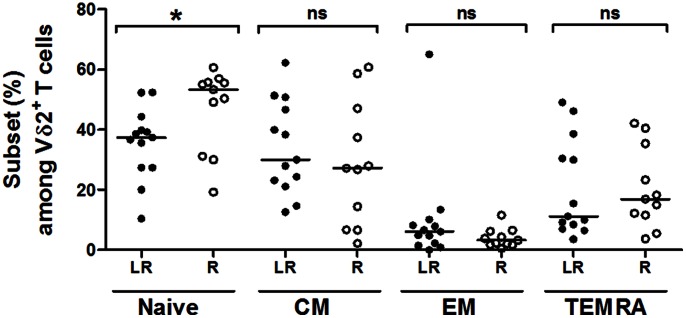
A reduced naive Vγ9Vδ2 subset in ex vivo LR EOC PBMCs.Percentages of naive (CD27+CD45RA+), central memory (CM) (CD27+CD45RA−), effector memory (EM) (CD27−CD45RA−) and terminally differentiated effector memory (TEMRA) (CD27−CD45RA+) cells among the Vδ2+CD3+ cells in ex vivo LR (n = 13) and R (n = 11) EOC PBMCs.